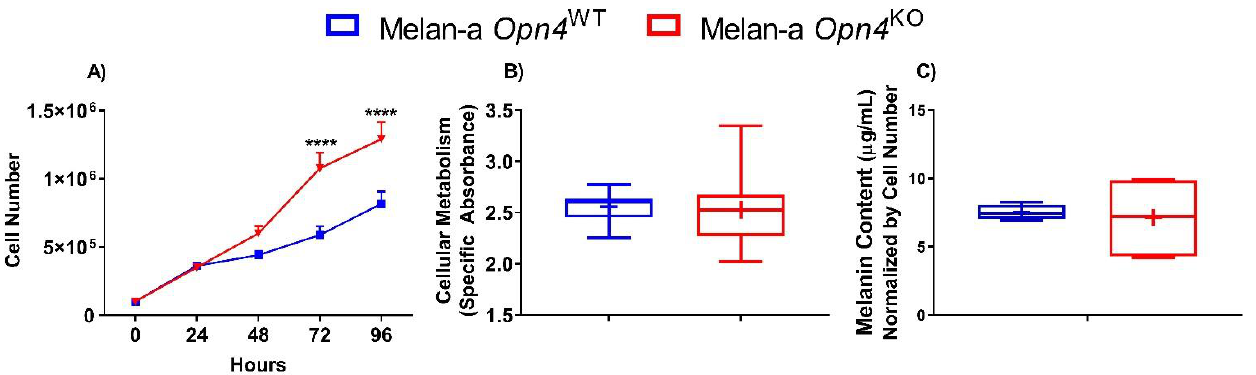
Figure 1. Cellular proliferation, metabolism, and melanin content of Opn4 WT and Opn4 KO normal melanocytes. ( A ) Cellular proliferation along 4 days ( n = 9); ( B ) specific absorbance of XTT after 24 h ( n = 10–21); ( C ) total (intra- and extra-cellular) melanin content on the fourth day ( n = 4–5). **** p < 0.0001.